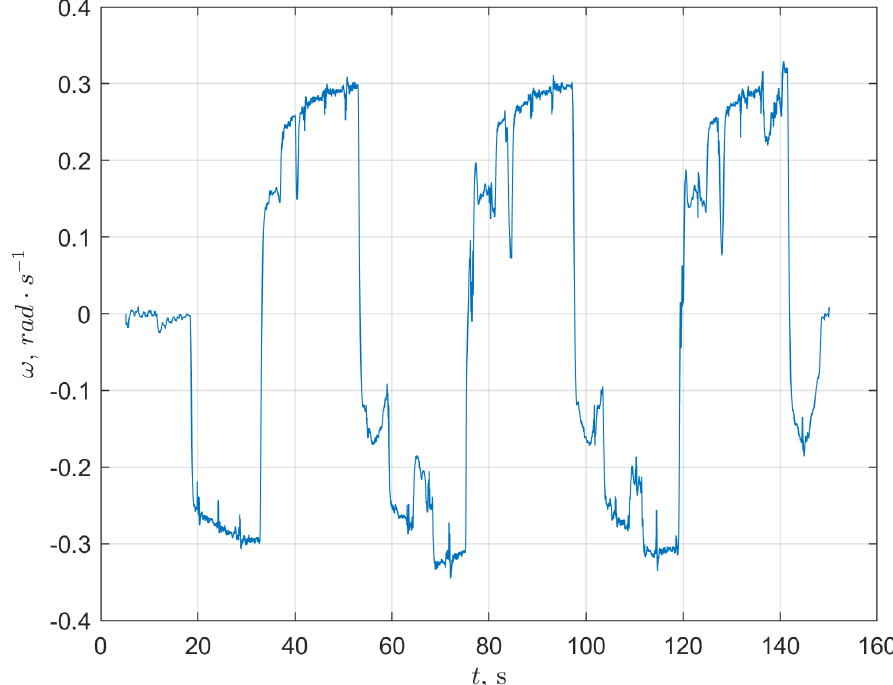
Figure 15. Changes in angular rate over time for the highest value of the cost function equal to 1.2970—track 1.